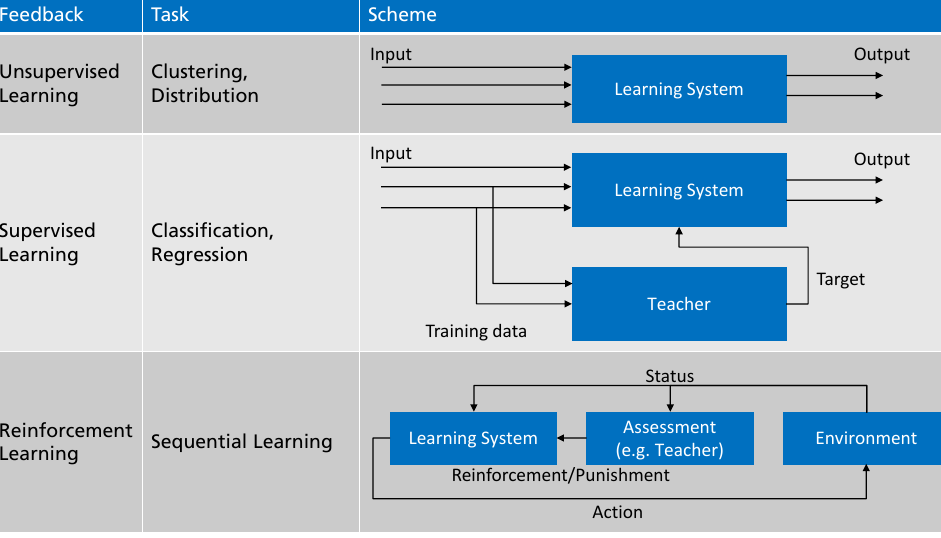
Figure 3. Methods of machine learning